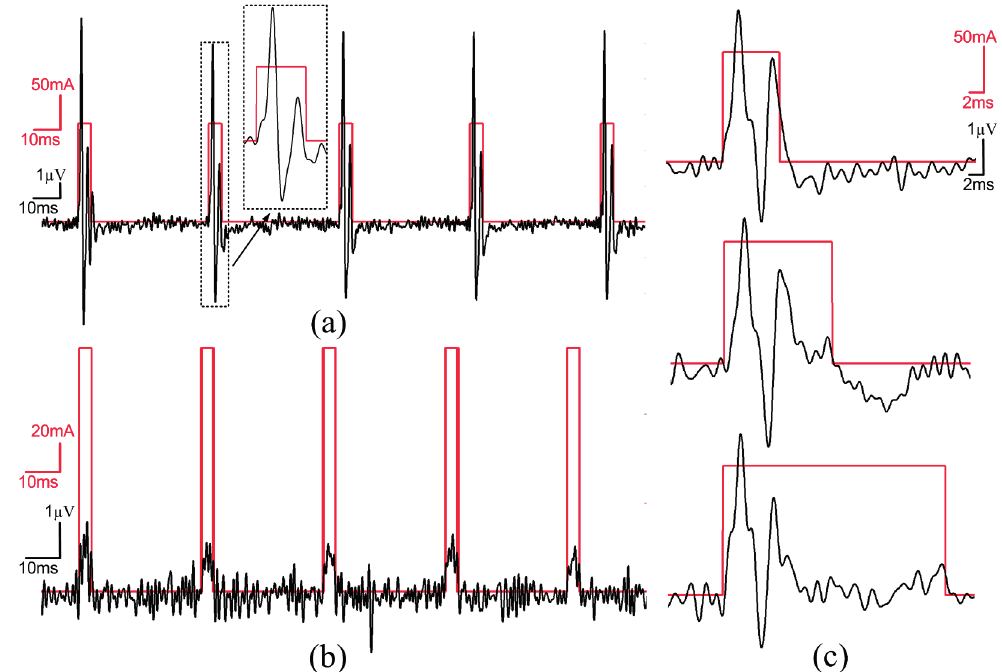
Figure 13. ( a ) Experimental results showing brain extracellular recording (black) in response to local optogenetic light activation (LED current in red), Pulse activations and recorded signals were driven trough the headstage; ( b ) In vivo light activation example without action potentials (spikes); ( c ) Example of spiking responses to three different light exposure times (5, 10, 20